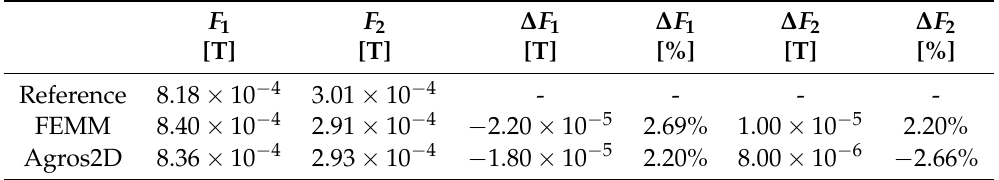
Table 1. The results of the validation run for the X 1 input compared to the reference values of F 1 and F 2 .